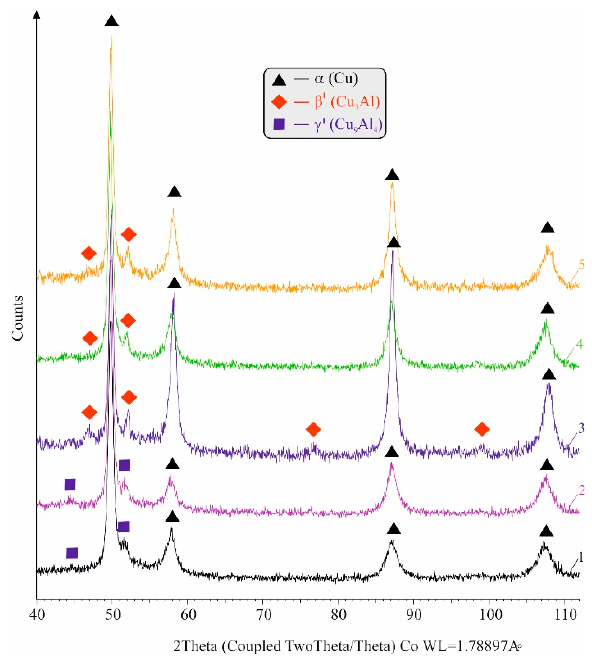
Figure 5. Phase analysis results for Cu-10Al-5Fe bronze: 1—as received; 2—annealed; 3—quenched; 4—quenched and tempered at 600 ◦ C; 5—quenched and tempered at 300 ◦